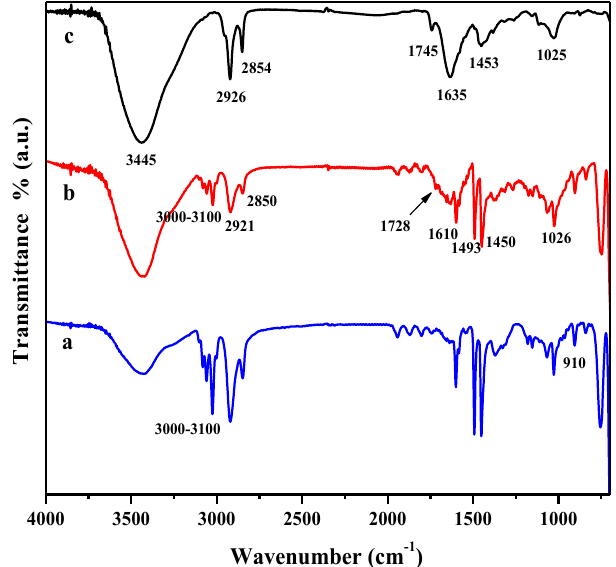
Figure 1. FTIR spectra of (a) neat polystyrene (PSTY); (b) reduced graphene oxide (RGO)-PSTY and (c) R-(GO-PSTY)